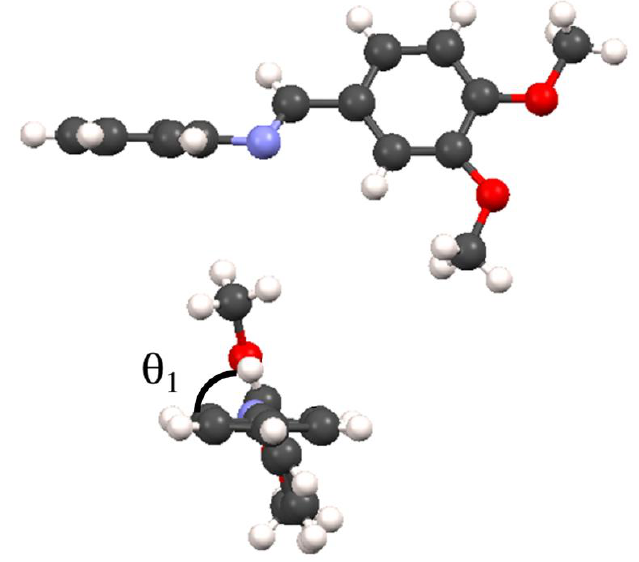
Figure 4. Face and side view of the X-RD structure of 1,2-dimethoxy, 4-(phenylimino) methylbenzene ( M3a